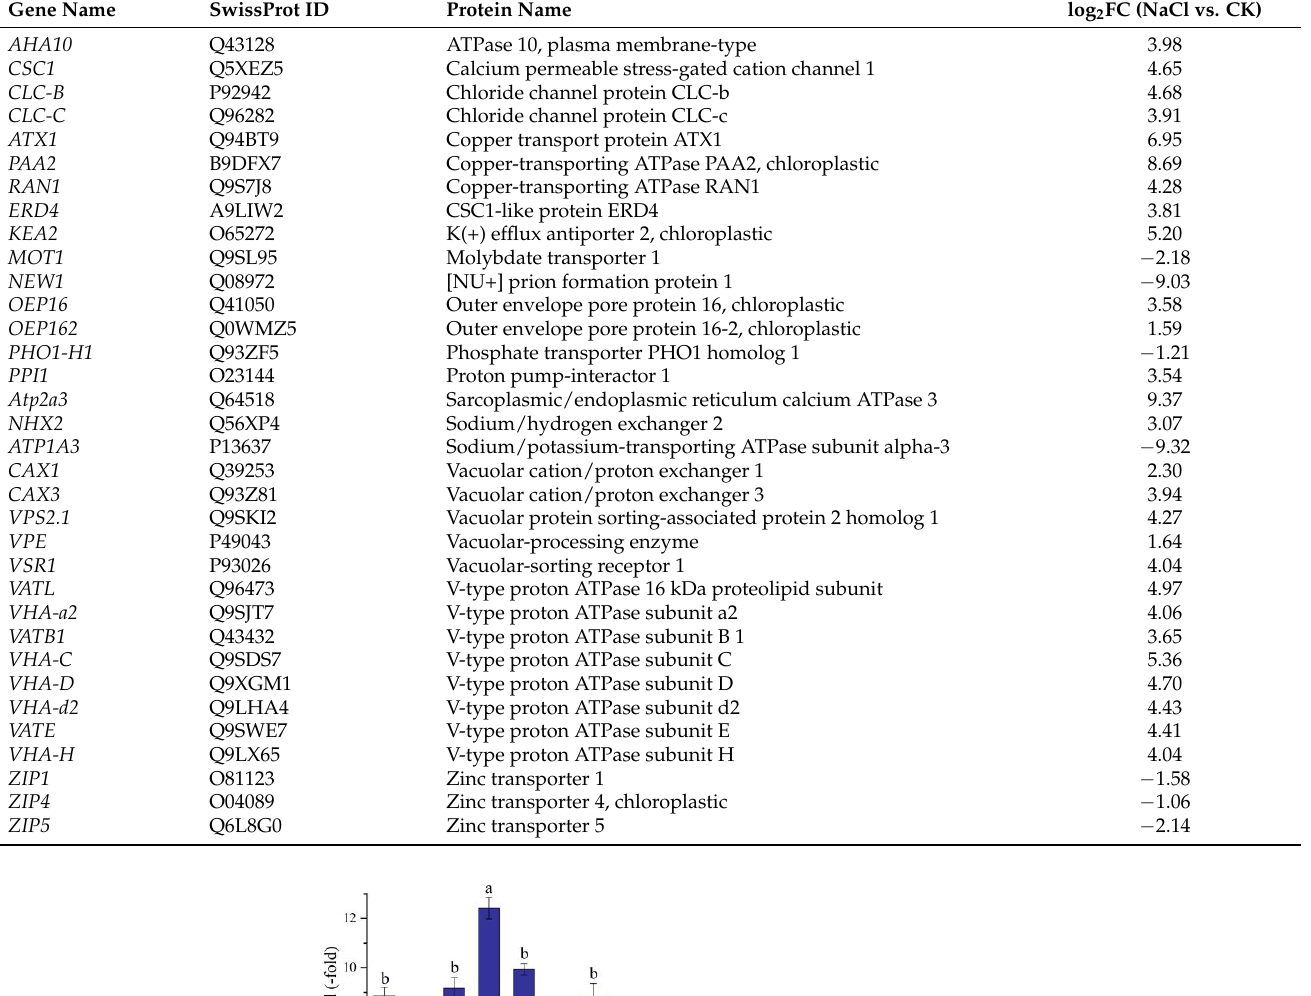
Table 8. Thirty-four DEGs directly associated with ion transport at 300 mmol/L NaCl vs. CK.